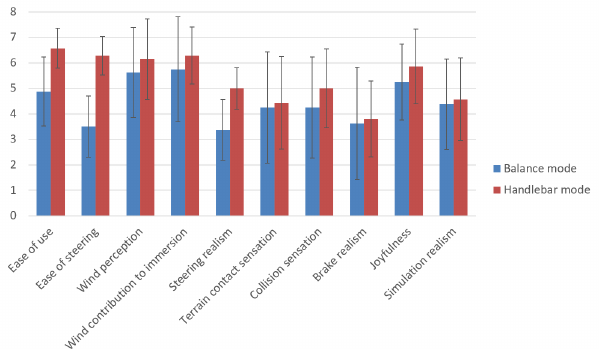
Figure 9. Averages values reported by participants after the second experi- mentthroughtheSimBike-specificquestionnaire.ParticipantsusingtheBal- ance mode (blue bars) and participants using the Handlebar mode (red bars).